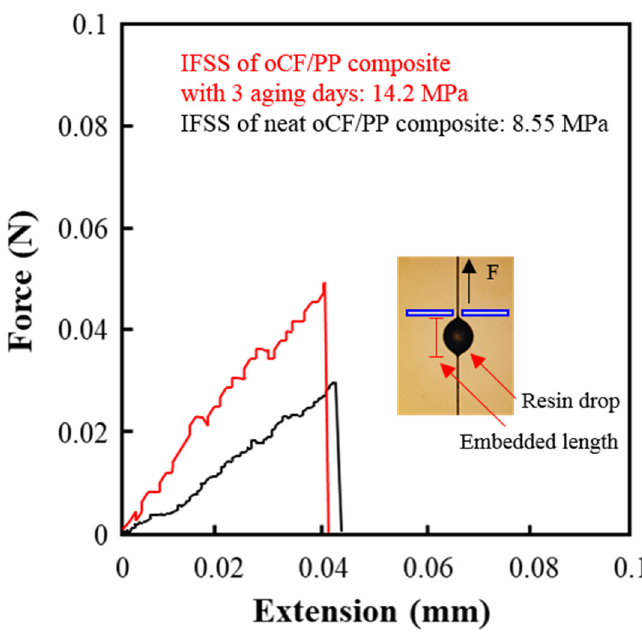
Figure 10. Results of the microdroplet pullout test of oCF/PP composites with PP aged for three days or with neat PP.